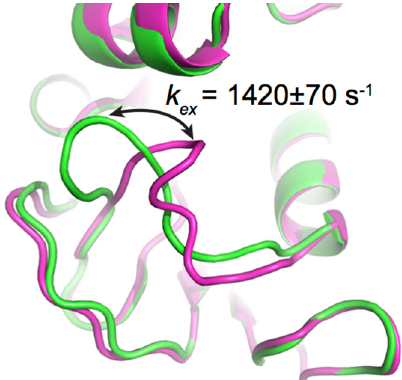
Figure 1. Conformational exchange experienced by the Met20 loop in E. coli DHFR, as probed by 15 N-CPMG NMR relaxation dispersion experiments. The CPMG experiment is particularly well suited to extract exchange rates ( k ex ) between two or more conformations in solution on the timescale of catalysis (ms) in many enzyme systems, offering a measure of comparison between conformational exchange experienced by the enzyme and its catalytic rate ( k cat ). This method can also provide quantitative information on low-populated “invisible” excited sub-states and their populations in solution ( p A and p B ). The cartoon representation illustrates a simplified view of the closed (green) and occluded (magenta) conformations sampled by the Met20 loop in E. coli DHFR as it catalyzes hydride transfer, an atomic-scale movement essential to bacterial DHFR function and correlated with substrate/cofactor recognition and turnover in this enzyme (reviewed in [28,35,40]). Depicted PDB structures are 1RX2 (green) and 1RX7 (magenta).